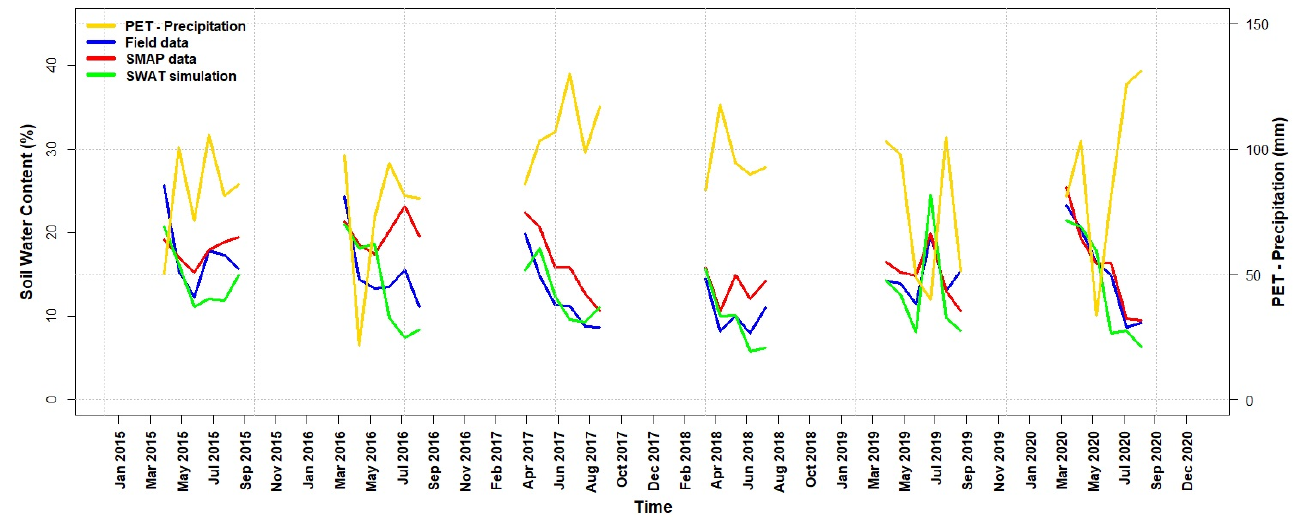
Figure 5. Monthly comparison soil water content between SWAT, SMAP, and field